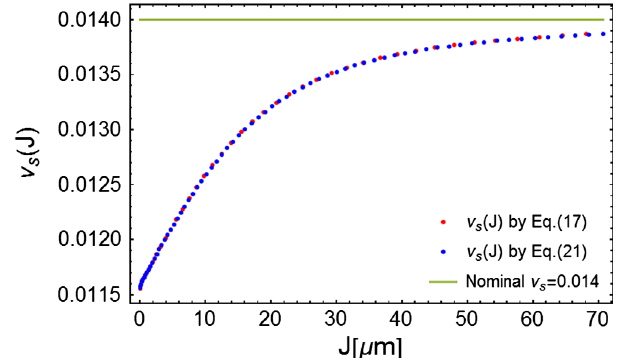
ð J Þ as a function of J at the design FIG. 4. Synchrotron tune ν s population. The red and blue dots are the calculated synchrotron tune using two different methods: Eq. (17) and Eq. (21), respec- ¼ 0 . 014 . tively. The green line is nominal synchrotron tune ν s